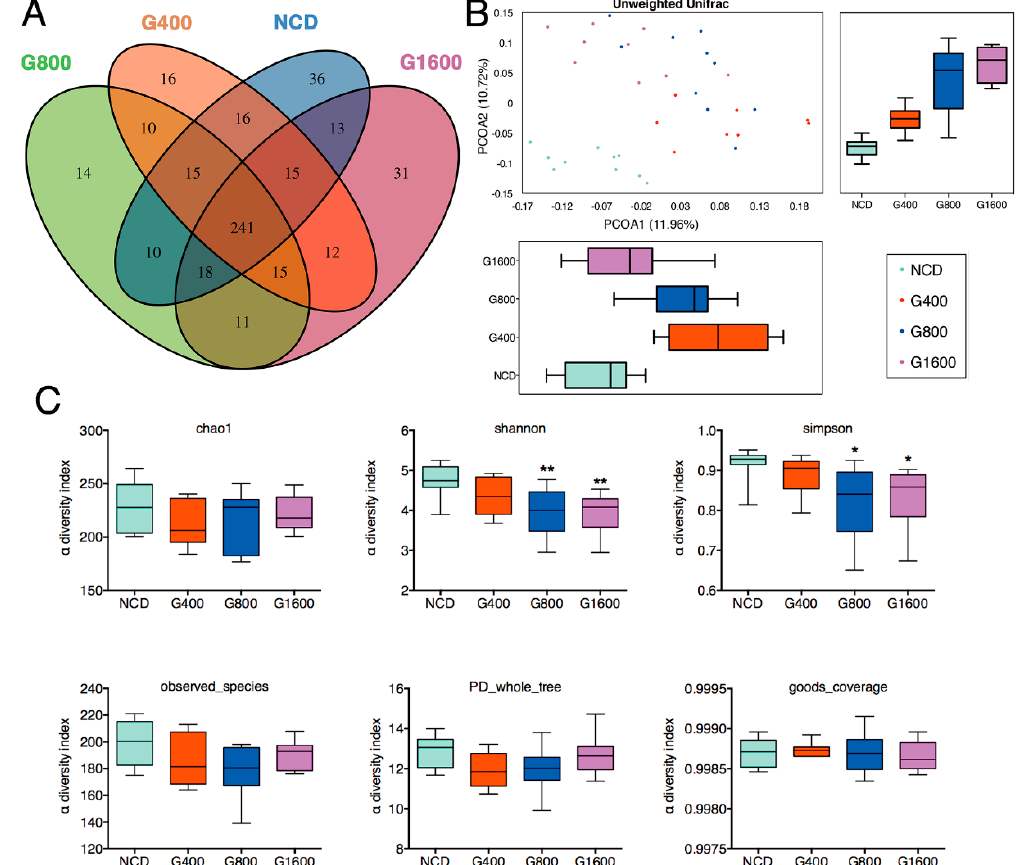
Figure 3. Change in fecal microbiota in mice fed with different doses of GML-supplemented diets. ( A ) Venn diagram of OTUs. ( B ) β -diversity analysis was performed by using the unweighted version of the UniFrac-based PCoA. ( C ) α -diversity analysis based on indices of chao1, Shannon, Simpson, Observed species, PD whole tree and goods coverage. Data were means ± SD ( n = 8–10); * p < 0.05 and ** p < 0.01 compared with the NCD group.